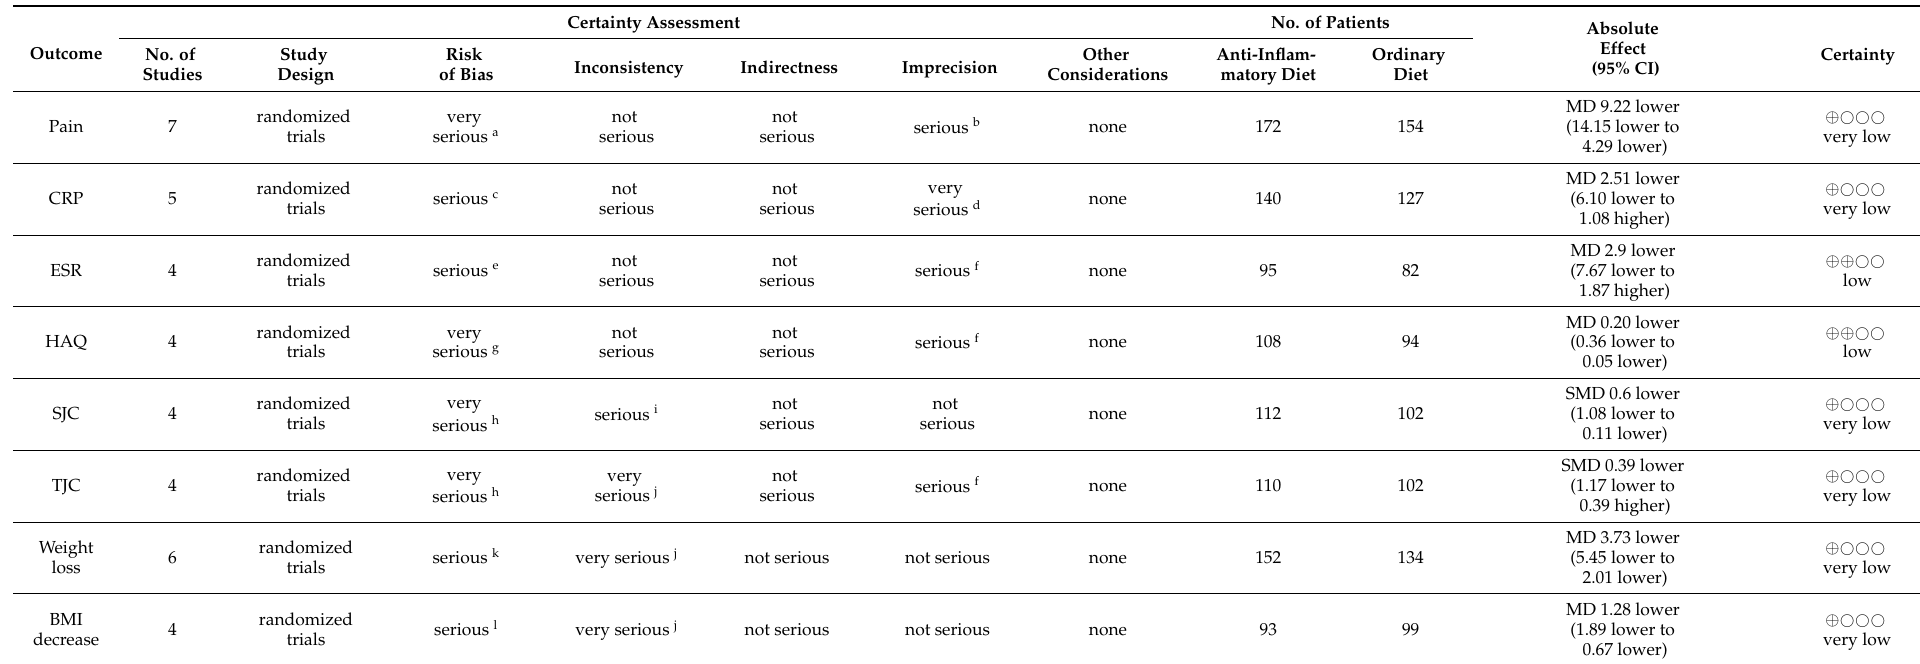
Table A1. Grading of Recommendations Assessment, Development and Evaluation (GRADE)